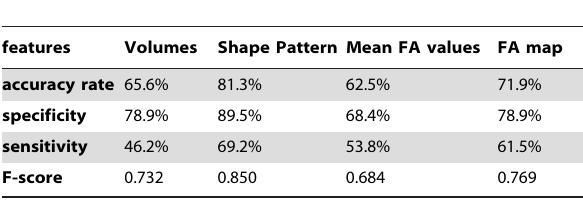
Table 2. Classification